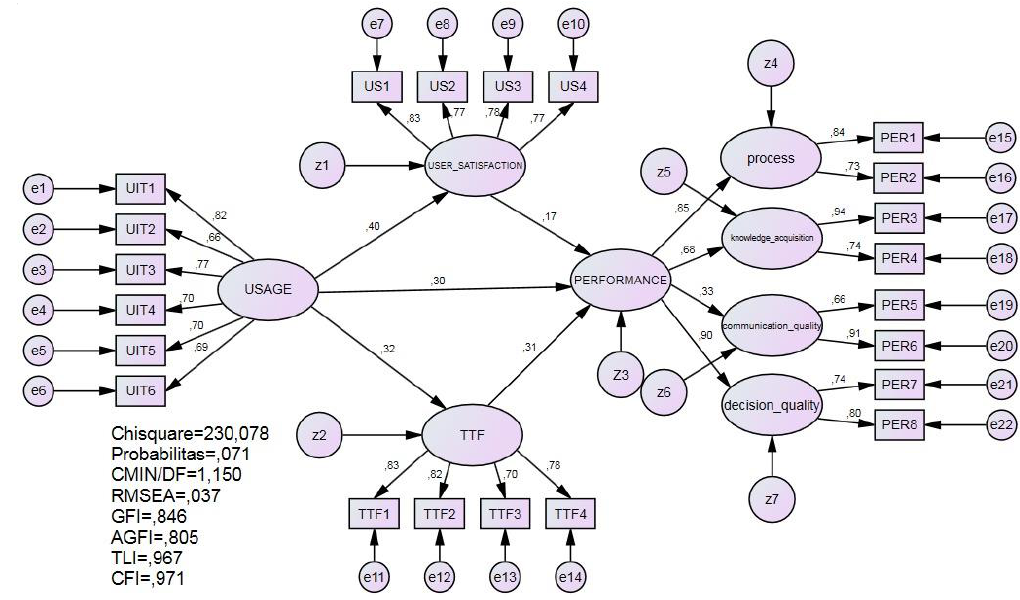
Figure 2 : Structural Equation Model (SEM)